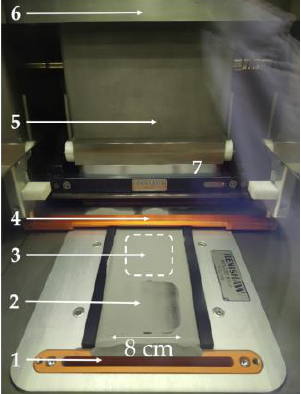
( b ) Figure 1. Praxair’s TruForm In718 powder’s ( a ) scanning electron microscopy image and ( b ) particle size distribution. In718 cubes (10 mm × 10 mm × 10 mm) were manufactured using Renishaw AM400 system (Wharton, UK) equipped with a 400 W, pulsed wave, Nd:YAG fiber laser (wave- length of 1080 nm and laser focus diameter of 70 µm). Figure 2 depicts the experimental set-up, along with its main elements, where the selective laser melting of the probes was carried out. It is first ensured that the building chamber is in an inert atmosphere, achiev- ing so, by flooding it with argon gas. A homogeneous layer of metallic powder (Inconel